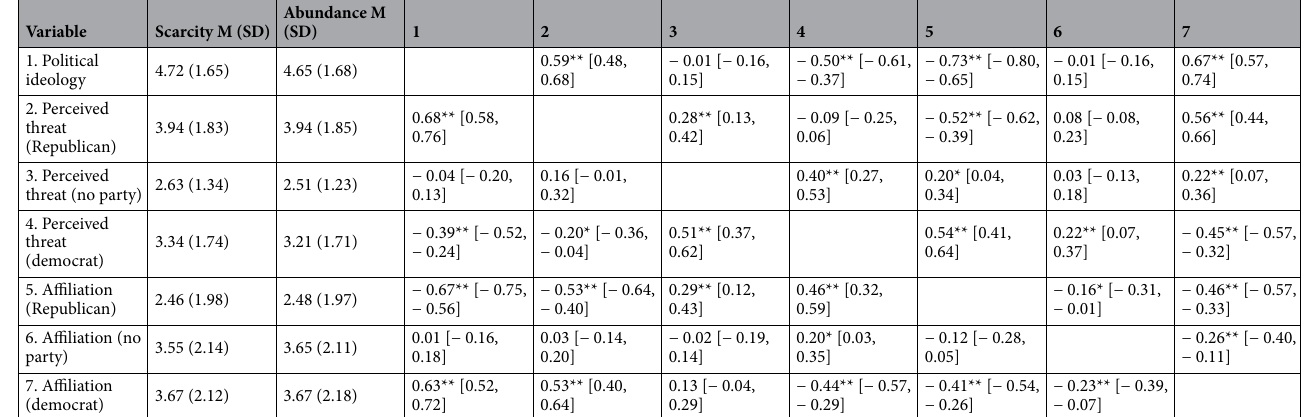
Table 5. Intercorrelations between partisanship characterization measures in experiment 2. M and SD are used to represent mean and standard deviation, respectively. Values in square brackets indicate the 95% confidence interval for each correlation. Participants in scarcity and abundance conditions are represented, respectively, below and above the diagonal. * indicates p < 0.05. ** indicates p <